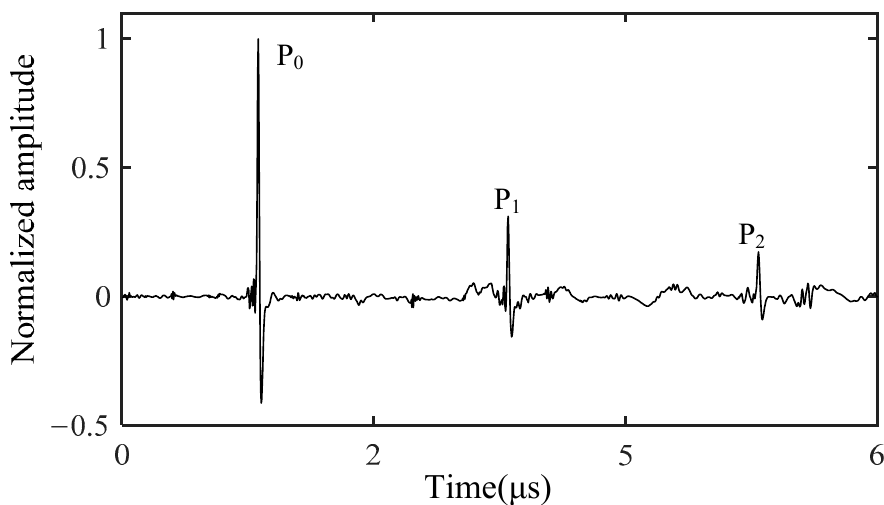
Figure 8. The signal collected by the system time delay calibration experiment.